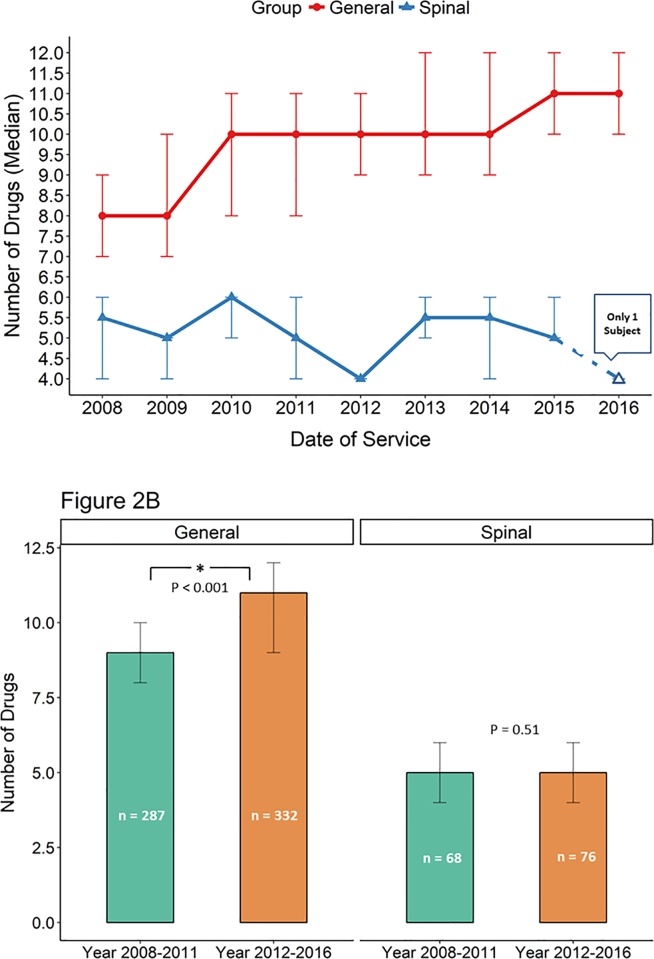
Number of drugs over time.—Panel A Number of drugs administered by year (median, quantiles as error bars).—Panel B Number of drugs administered for the first and second halves of each cohort. There was no statistically significant difference between the first half and second half for SA cases. There was a statistically significant difference between the first half and second half GA cases, p <0.001 (Wilcoxon rank sum test). Error bars represent Q1 and Q3.